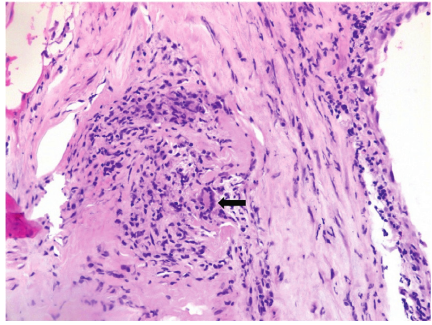
Figure 3: Giant cell indicated in arrow along with granulomatous changes.